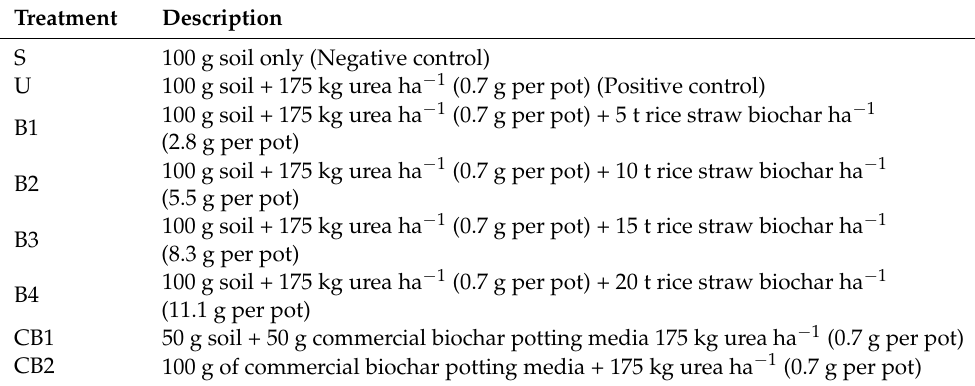
Table 3. Treatments evaluated in ammonia volatilization